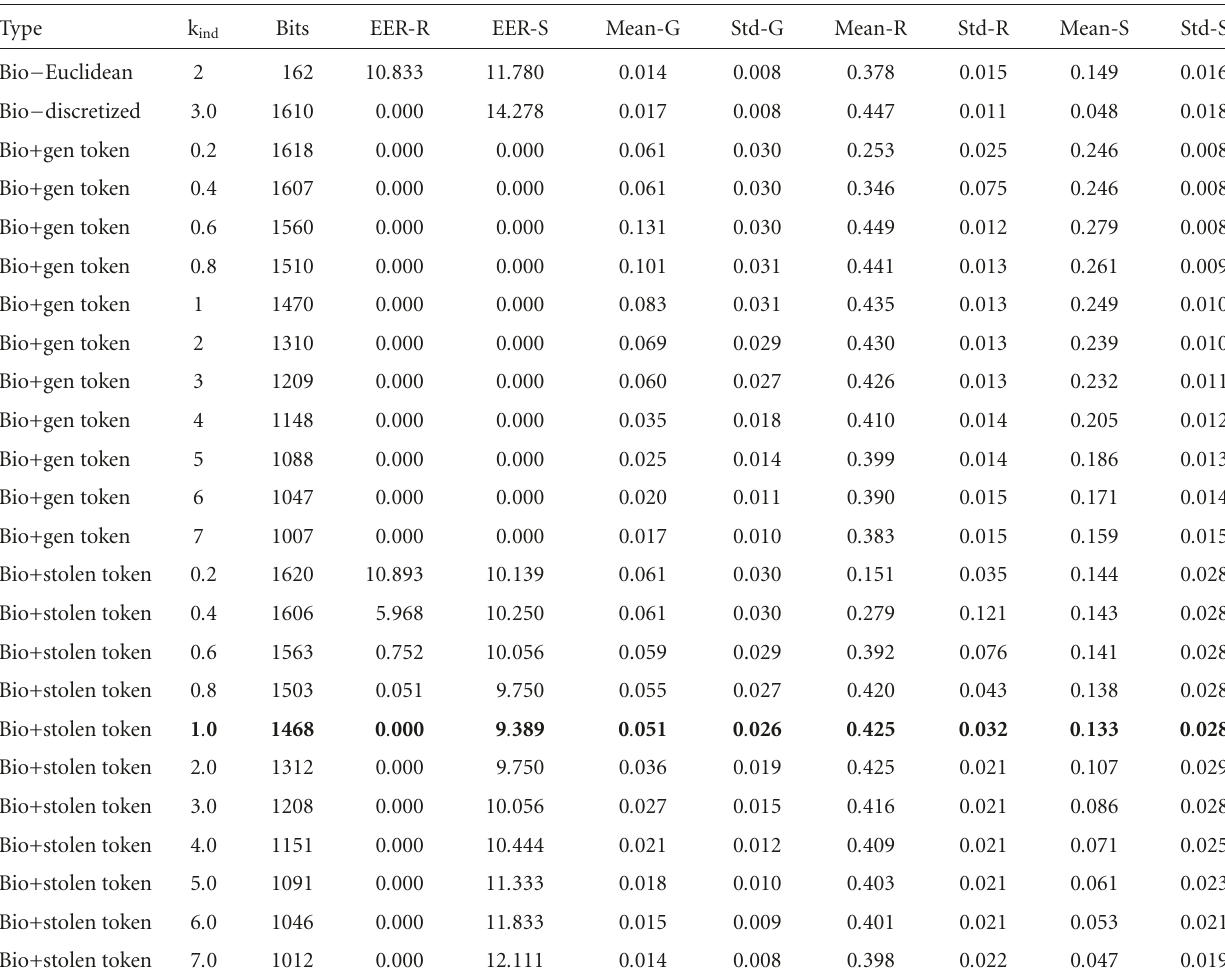
Table 1: Comparison of EER and mean distribution for various configurations of k ind